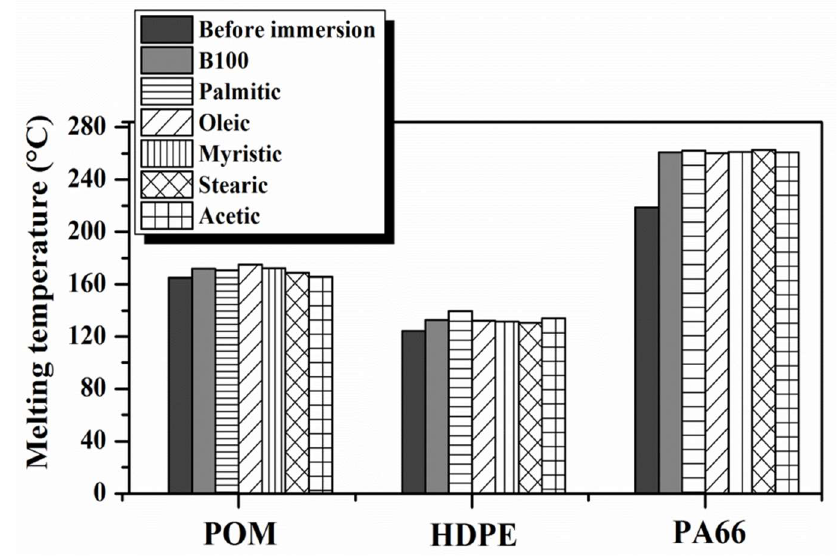
Figure 4. Melting temperature variation during DSC analysis for the polymers after immersion in B100 and B100–acid blends. Polymers 2018 , 10 , x FOR PEER REVIEW